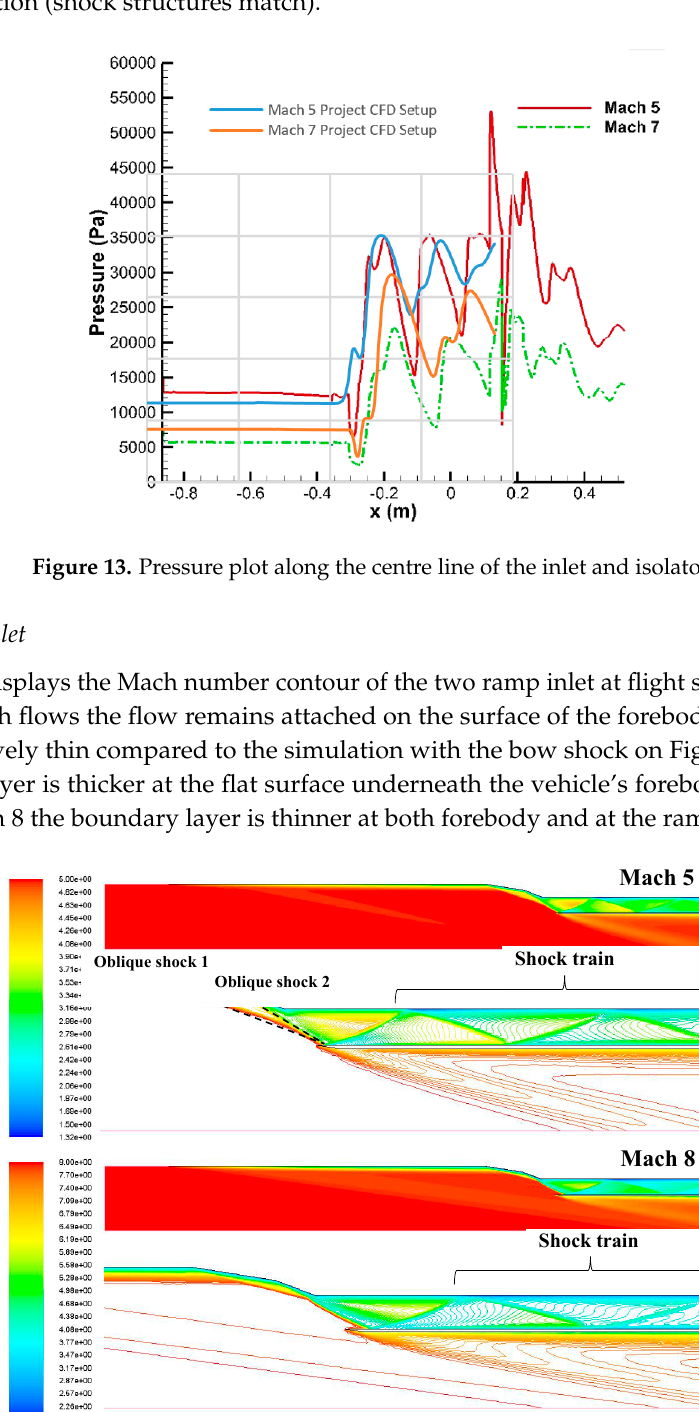
Figure 14. Mach contour of the two ramp inlet at Mach 5 and 8.